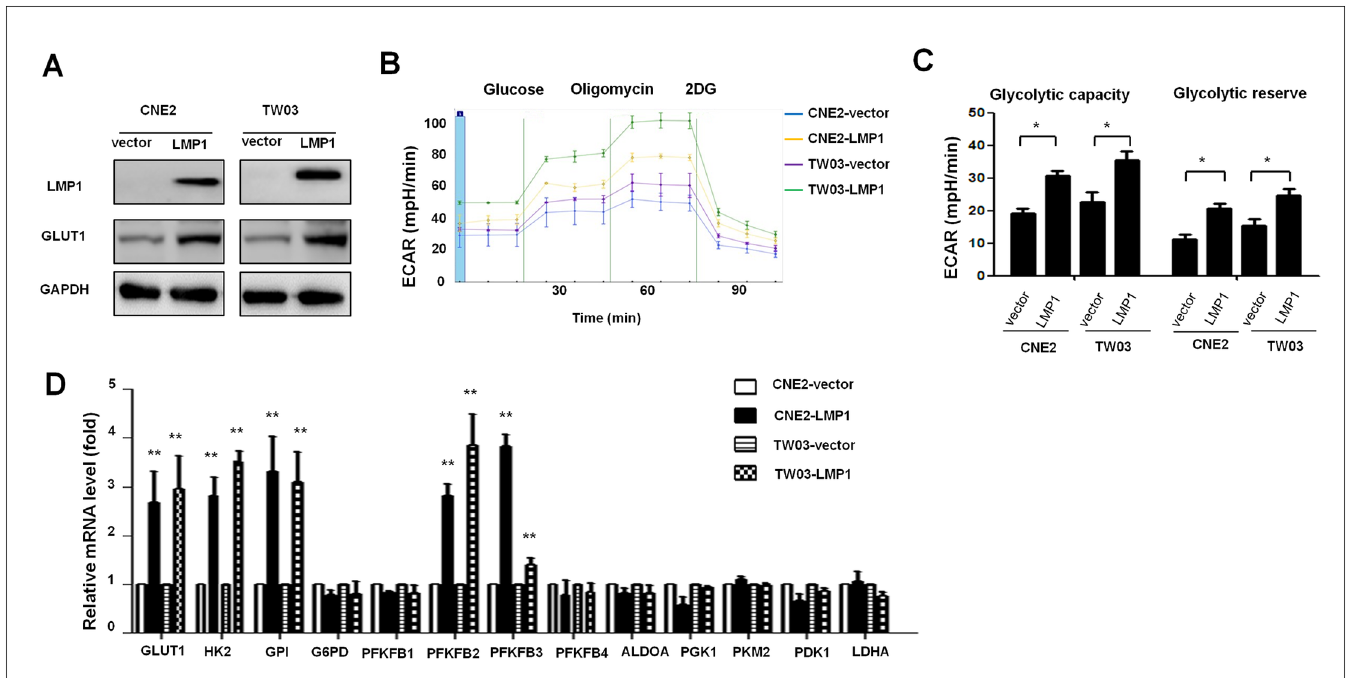
Fig 2. LMP1 increased glycolysis and the expression of glycolysis-related genes in NPC cells. ( A ) ExogenousEBV oncoprotein LMP1 was stably overexpressed in the NPC cell lines CNE2 and TW03 followinglenti-LMP1transfection, and the lenti-vector was includedas control. WB showedthat the expressionof LMP1 and GLUT1 was increasedin CNE2-LMP1 and TW03-LMP1 cells comparedwith that in CNE2-vector and TW03-vector cells, and GAPDH was includedas a control. One representative experiment of five independent experiments is shown. ( B-D ) ECAR assay results. CNE2-vector, CNE2-LMP1,TW03-vector and TW03-LMP1 cells were cultured in base DMEM media with no glucose or glutamine. ECAR was assessedafter the addition of 10 mM glucoseand in responseto the metabolicinhibitoroligomycinand the glucoseinhibitor2-DG. The time course and calculations for ( B ) glycolytic capacity and ( C ) statistical analysisof glycolyticcapacity and glycolytic reserve are shown. ( D ) The relative mRNA levels of glycolysis-relatedgenes, includingGLUT1, HK2, GPI, PFKB1, 2, 3 and 4, ALDOA, PGK1, PKM2 and LDHA, in CNE2-vector, CNE2-LMP1, TW03-vector and TW03-LMP1 cells were measuredvia real-time qRT-PCR. Statistical results are representative of at least three experiments performed in triplicate. All values are shown as the means ± SEM; * indicatesP < 0.05. ** indicatesP < 0.01.